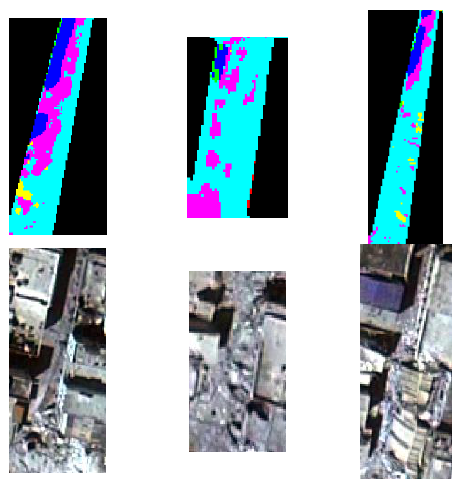
Fig 7. Some paths deemed blocked by the algorithm After running the algorithm for the entirety of the 60 selected paths, 23 were reported to remain un-blocked while the other 37 were detected as blocked paths; Fig.8 shows the obtained damage map from the algorithm.